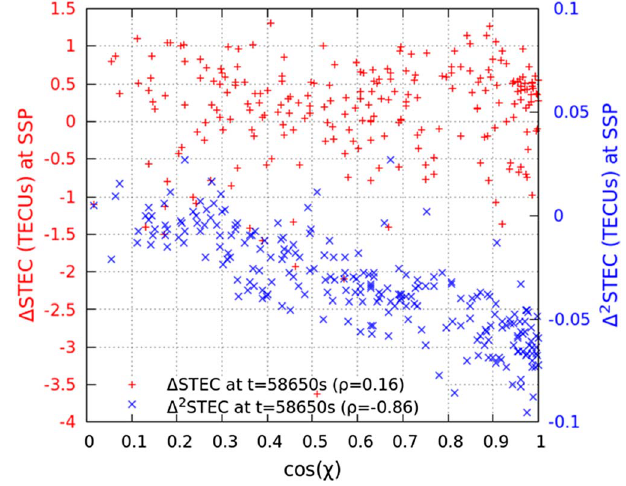
Fig. 6. (cid:1) STEC j (red) and (cid:1) 2 STEC j (blue) as a function of the i i cosine of the angular distance between the SSP and the IPP at 58 650 s of March 11, 2015.